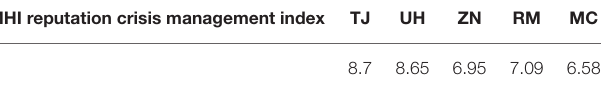
TABLE 2 | MHI reputation crisis management index